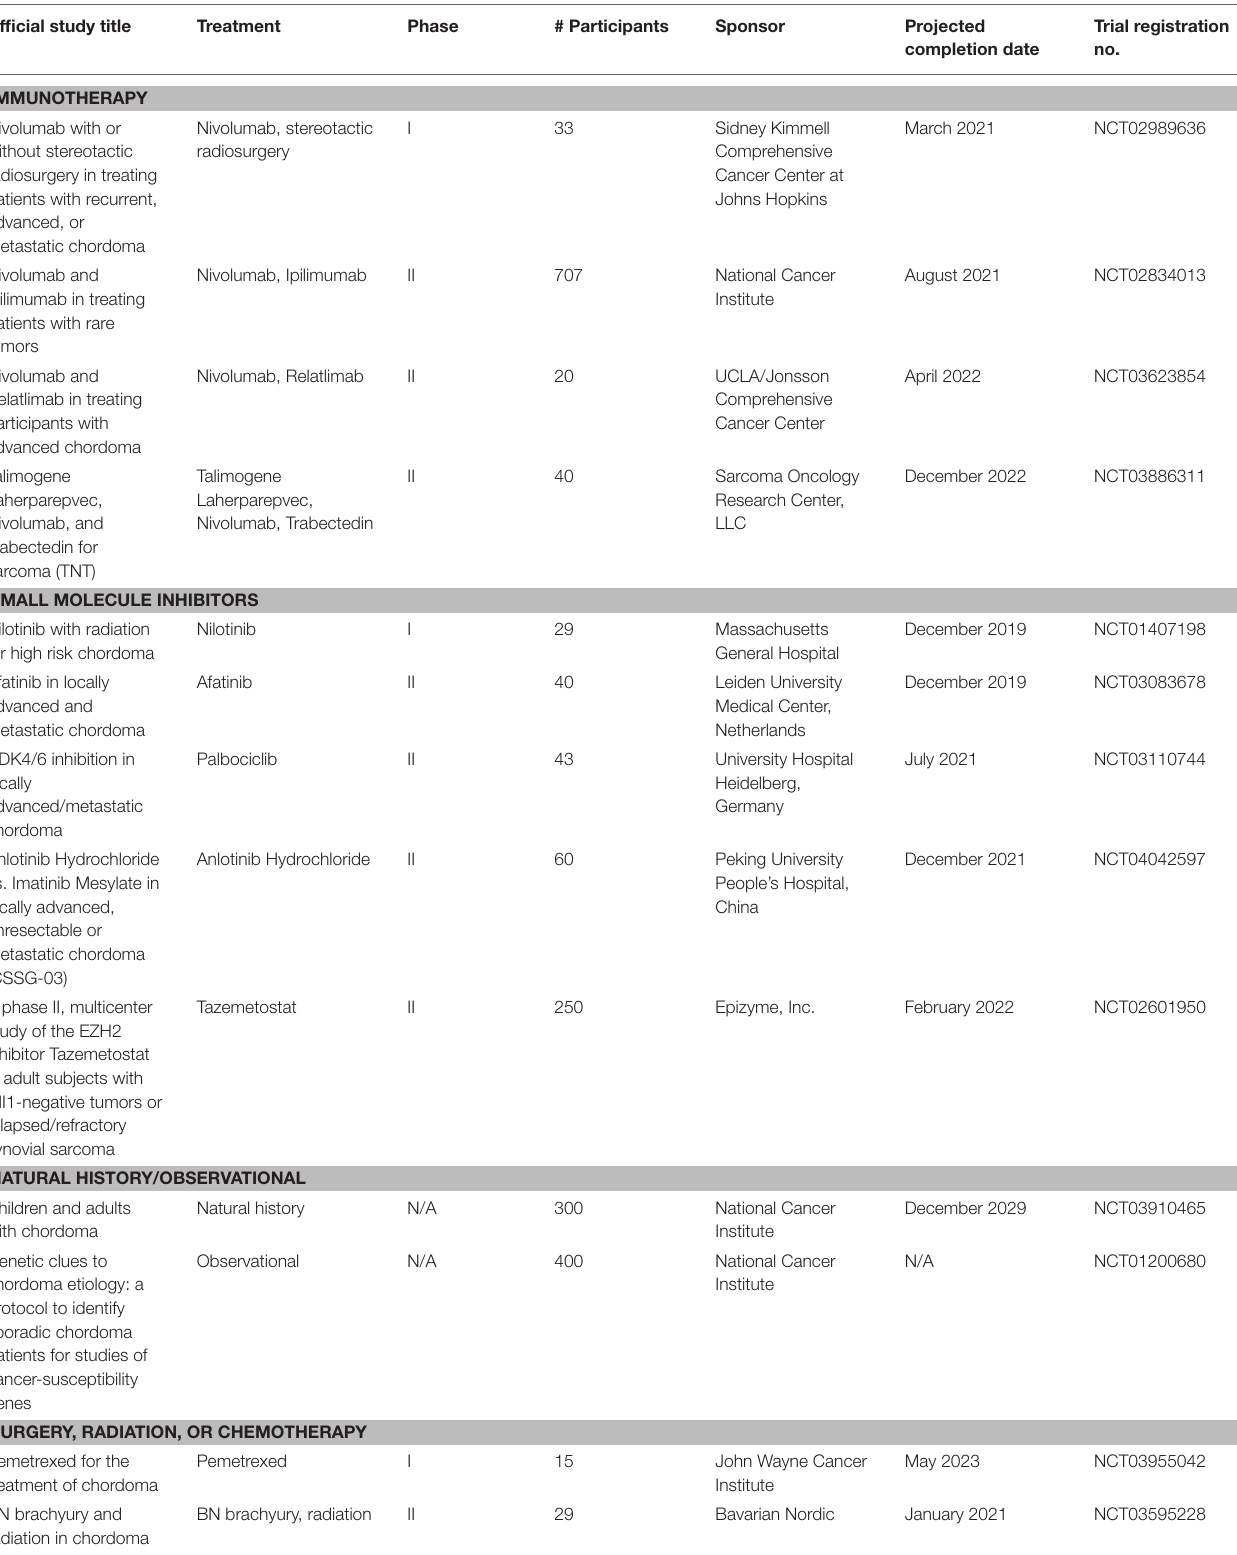
TABLE 1 | Active trials for surgical, radiation, and medical therapies for chordoma (extrapolated from ClinicalTrials.gov; December 30,